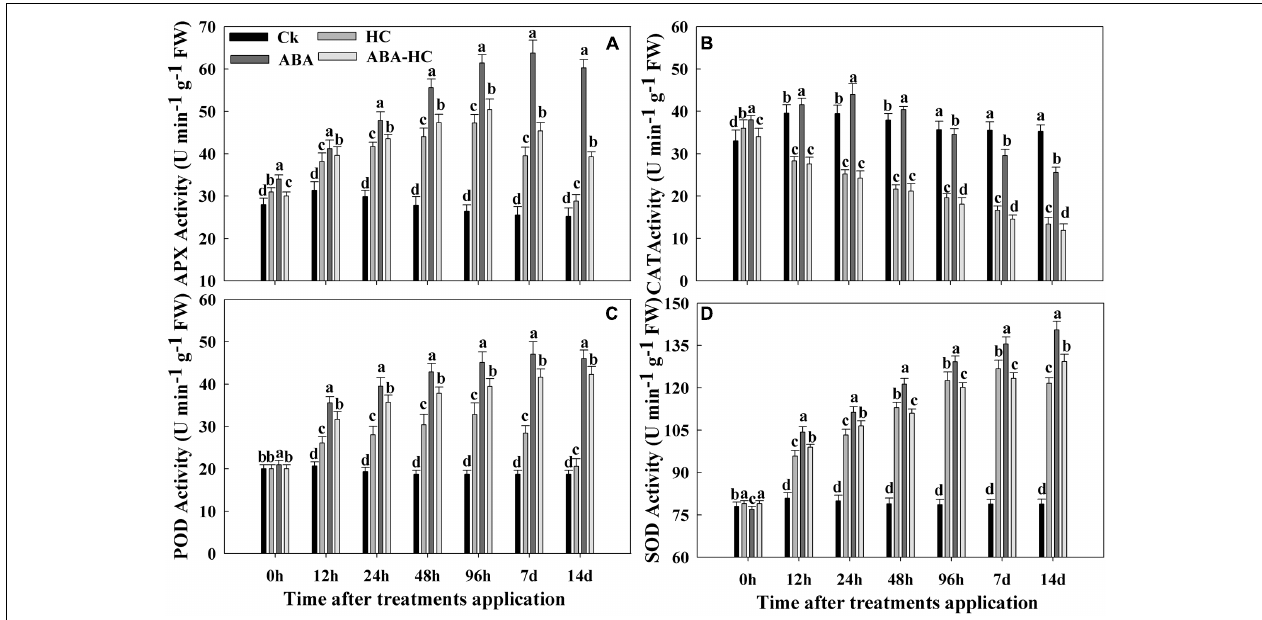
FIGURE 3 | Changes in the activities of antioxidant enzymes (A) APX, (B) CAT, (C) POD, and (D) SOD in the buds of cv. ‘Shine Muscat’ treated with HC, ABA and ABA-HC or water and sampled at 0, 12, 24, 48, 96 h, 7 and 14 days after treatement. Verticle lines above the means bars indicate standard error ( n = 3; p = 0.05) using Tukey’s HSD post hoc test. a–d represents significant difference between